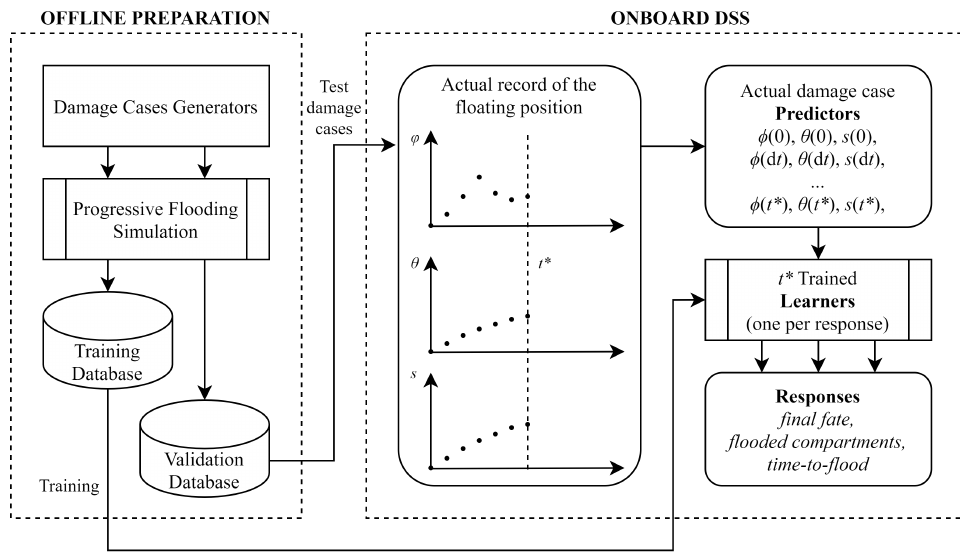
Figure 1. Flowchart of the classification